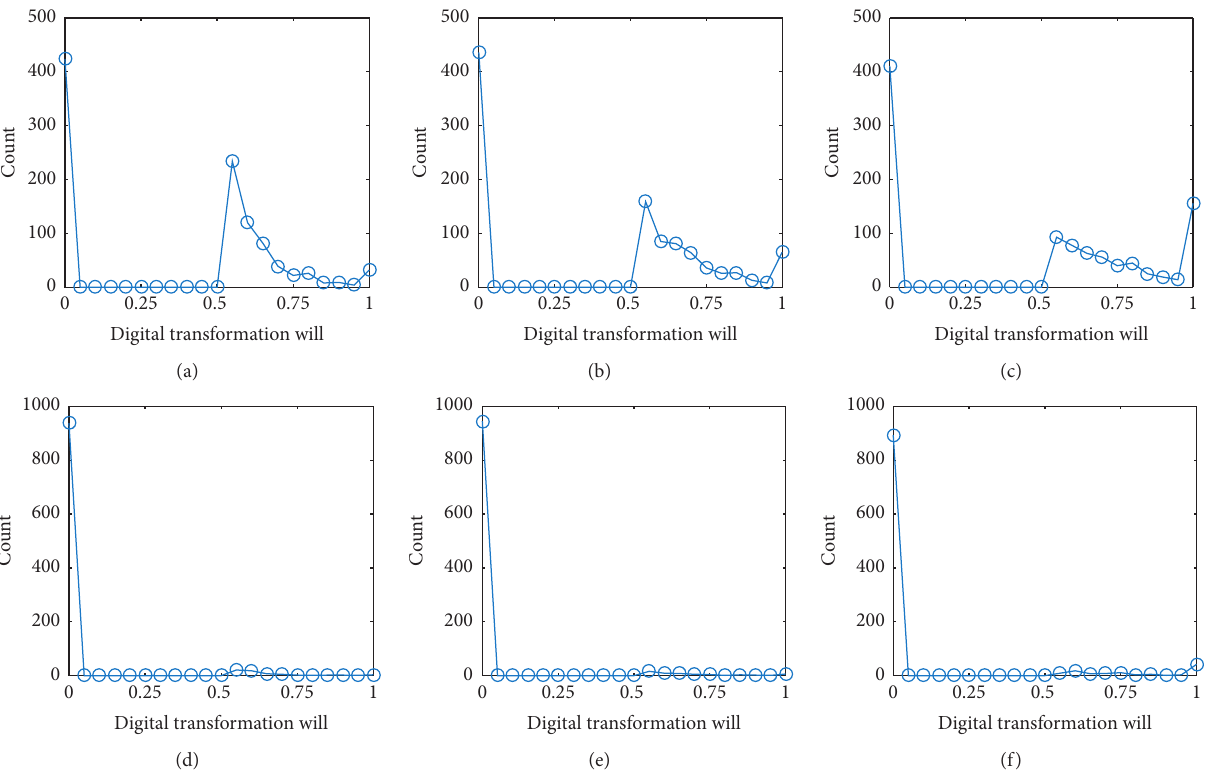
Figure 10: Enterprises’ transformation willingness under different environmental policies: (a) pr � 0.3, Cu � 1, Cb � 2; (b) pr � 0.5, Cu � 1, Cb � 2; (c) pr � 0.7, Cu � 1, Cb � 2; (d) pr � 0.3, Cu � 2, Cb � 4; (e) pr � 0.5, Cu � 2, Cb � 4; (f) pr � 0.7, Cu � 2, Cb �